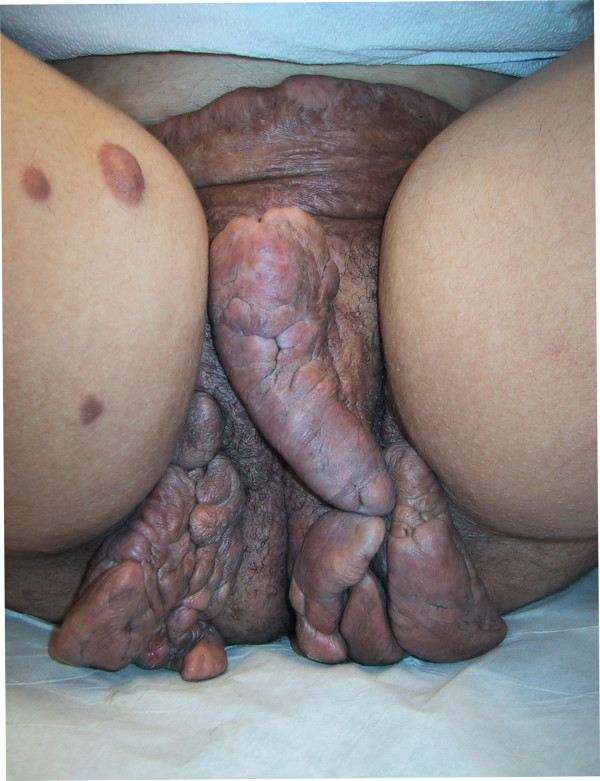
Pre-therapy photograph of giant perineal keloid, showing lobulated appearance.